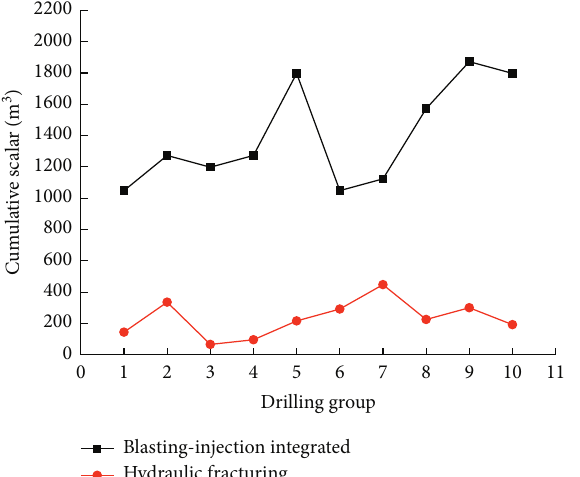
Figure 14: Comparison curve of cumulative scalar volume of gas drainage before and after blasting-injection integrated antireflection